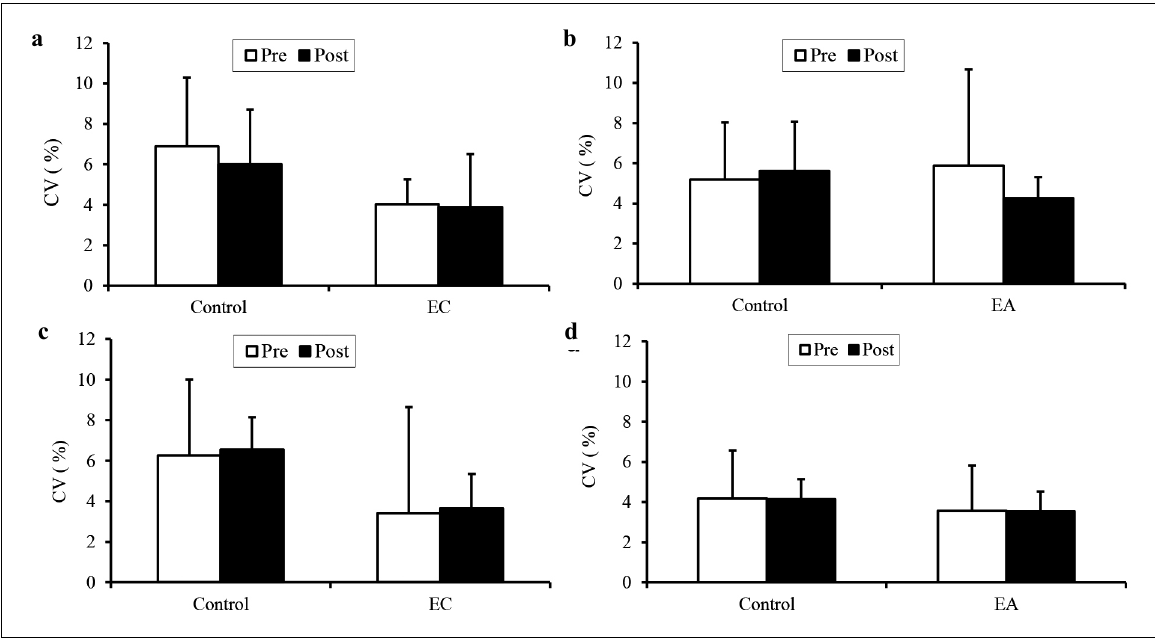
Figure 3. Mean values (coefficient of variation (CV)) of submaximal isometric torque variability in control, Experimental Chronic pain (EC) and Experimental Acute pain (EA) groups pre and post brace wear. (a and b) knee extension; (c and d) knee flexion